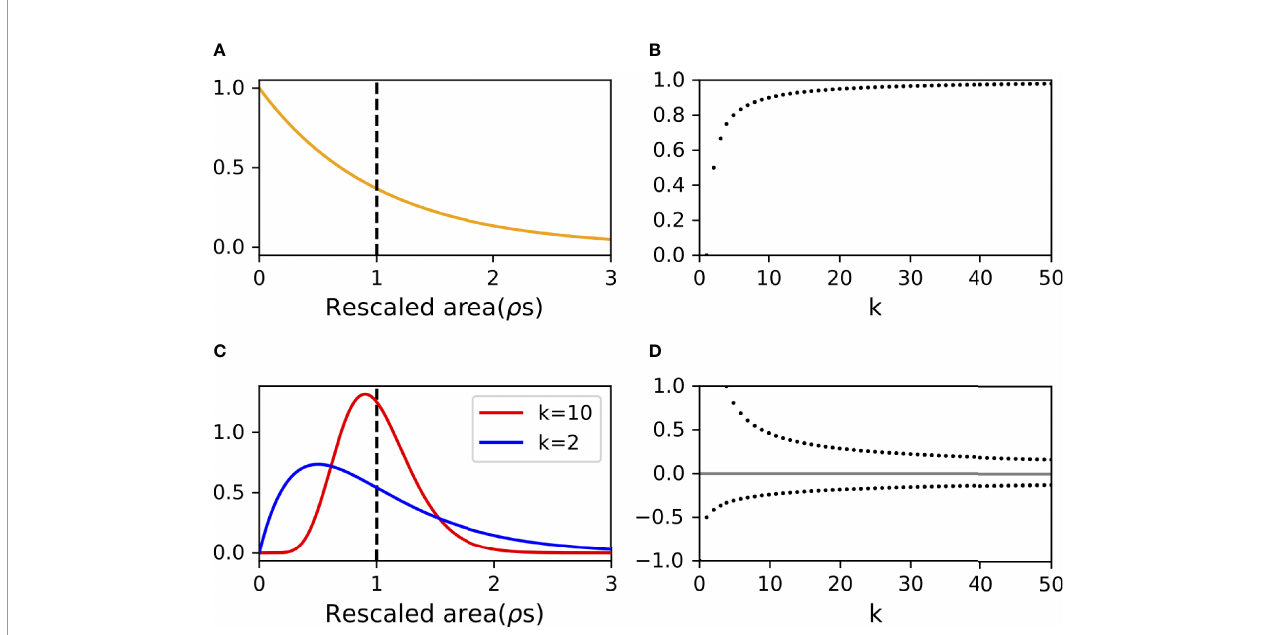
FIGURE 2 | Probability distribution functions governing the minimum searched area (A) (Eq. 6) and its sample mean (C) (Eq. 9) assuming random fi sh dispersion. Note that the “ Rescaled area ” (nondimensional units) in (A) and (C) is the minimum searched area rescaled by the equivalent area r − 1 . The dashed vertical lines indicate the point at which the minimum searched area equals the equivalent area. Panels (B, D) plot the bias in the mode population density from the actual value ( r (cid:2) s ∗ in Eq. 13) and the uncertainty in the estimation of the population density ( d ±/ r in Eq. 12), respectively. Note that the upper bound of the uncertainty exceeds unity for k < 4 in panel (D) (See Eq.